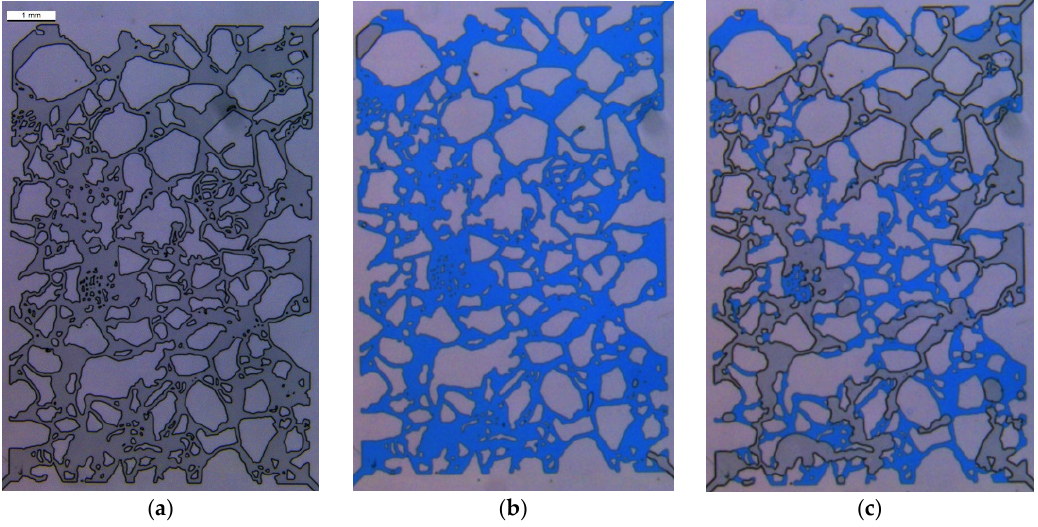
Figure 5. Gas flooding liquid phase retention in 200 μ m model. ( a ) Dry microfluidic chip model; ( b ) Saturated liquid model; ( c ) After 500 mbar constant gas pressure displacement.